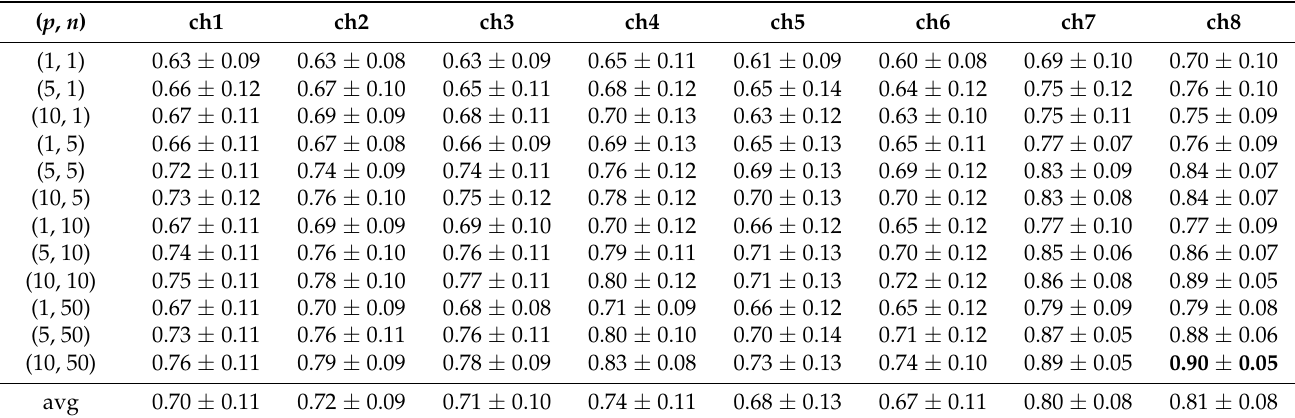
Table 4. A3S-Rec dataset: AUPRC of the 2-way 10-shot A3S-Synth prototypical model tested on individual recordings for each acquisition